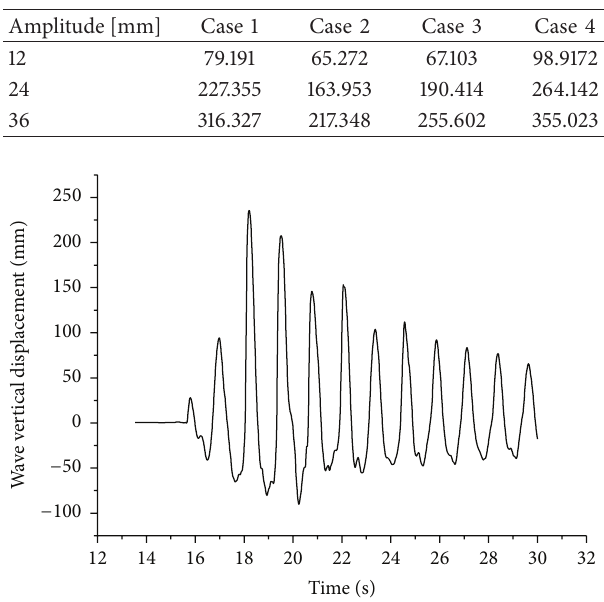
Figure 4: The vertical displacement time history of sloshing wave of case 1 with 24mm amplitude.